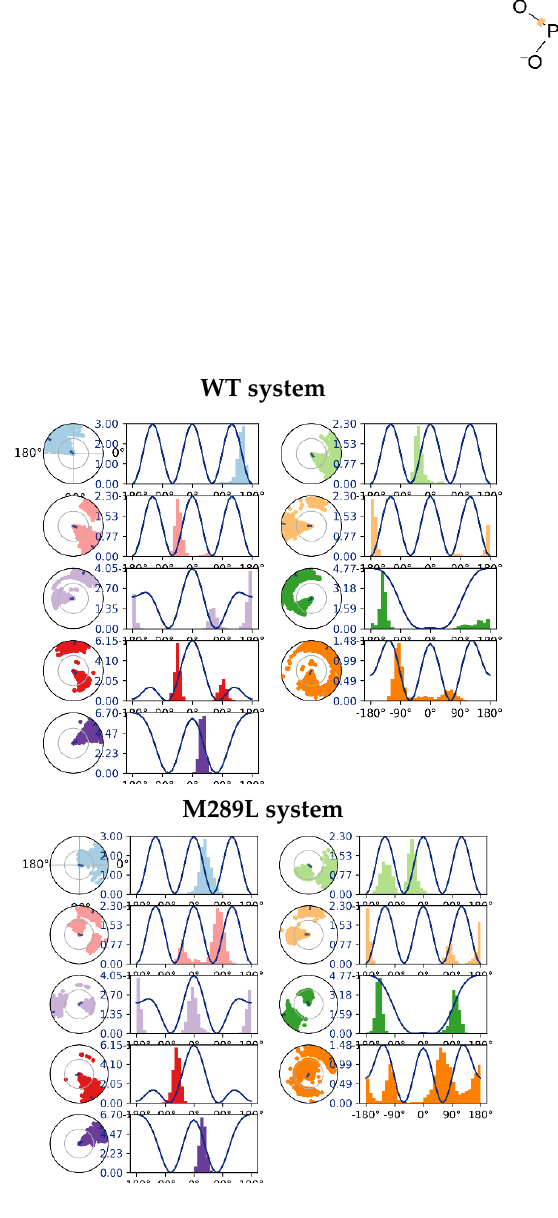
Figure 9. The dihedral angle of GS − 461203 profiles during 500 ns MDS which is the conformational progression of the nine rotatable bonds of GS-461203. The dial plots describe the conformation of the torsion throughout the course of the simulation. The beginning of the simulation is in the center of the radial plot and the time evolution is plotted radially outwards. The bar plots summarize the data on the dial plots, by showing the probability density of the torsion. In addition, the 2D structure of GS-461203 in the top panel is for reference.